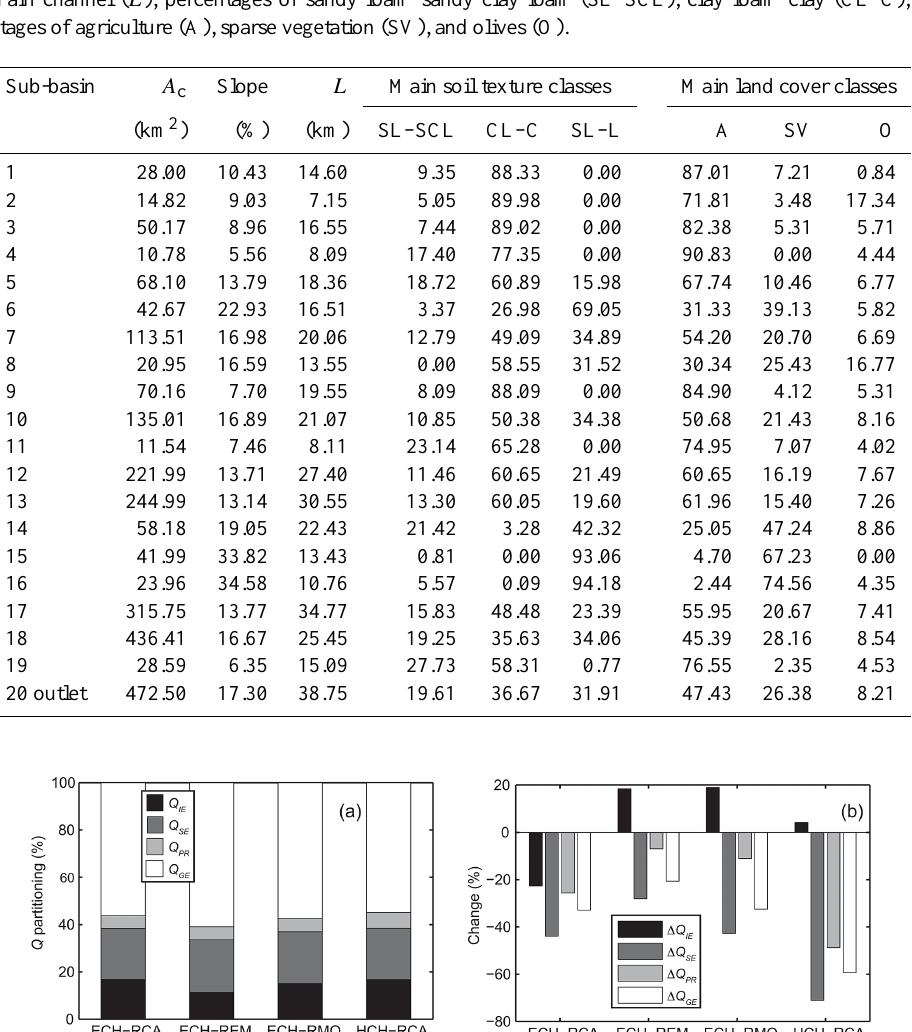
Figure 8. (a) Partitioning of Q at the RMB outlet in the REF period among the four runoff generation mechanisms: infiltration excess ( Q IE ), saturation excess ( Q SE ), perched return flow ( Q PR ), and groundwater exfiltration ( Q GE ) runoff components. (b) (cid:49)Q for the runoff